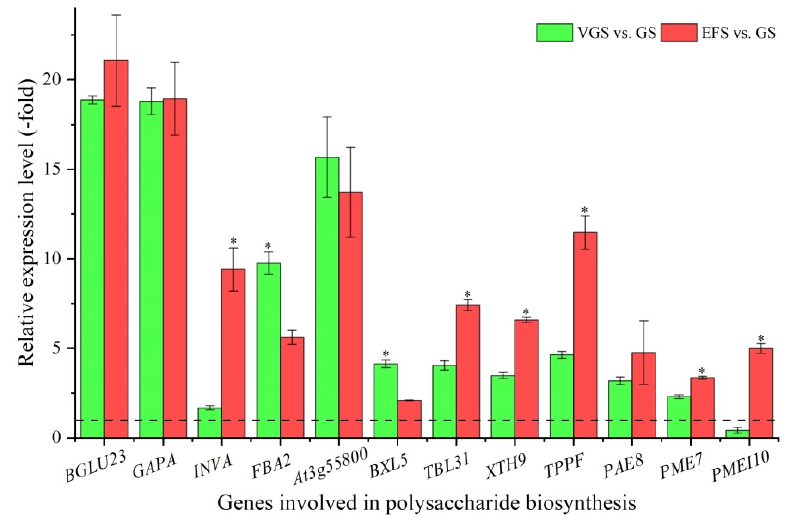
Figure 6. The relative expression level of genes involved in polysaccharide biosynthesis at VGS and EFS vs. GS, as determined by qRT-PCR (mean ± SD, n = 3). The “*” represents a significant difference ( p < 0.05) at different growth stages for the same gene.